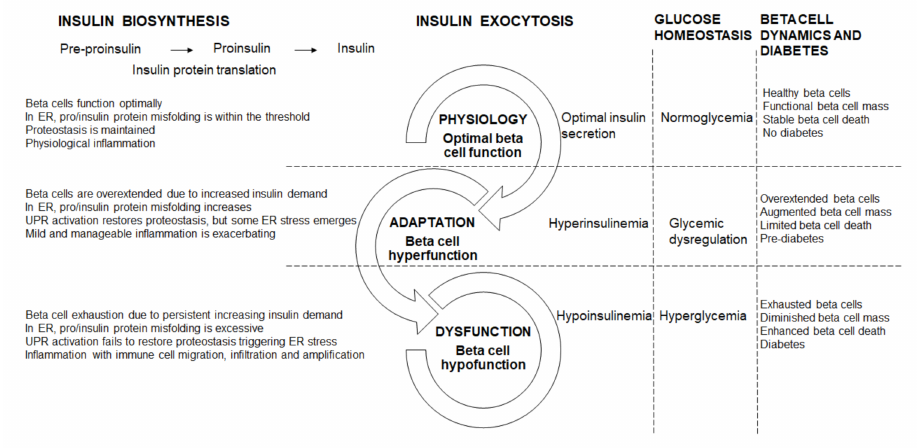
Figure 1. Beta cell physiology and dysfunctional